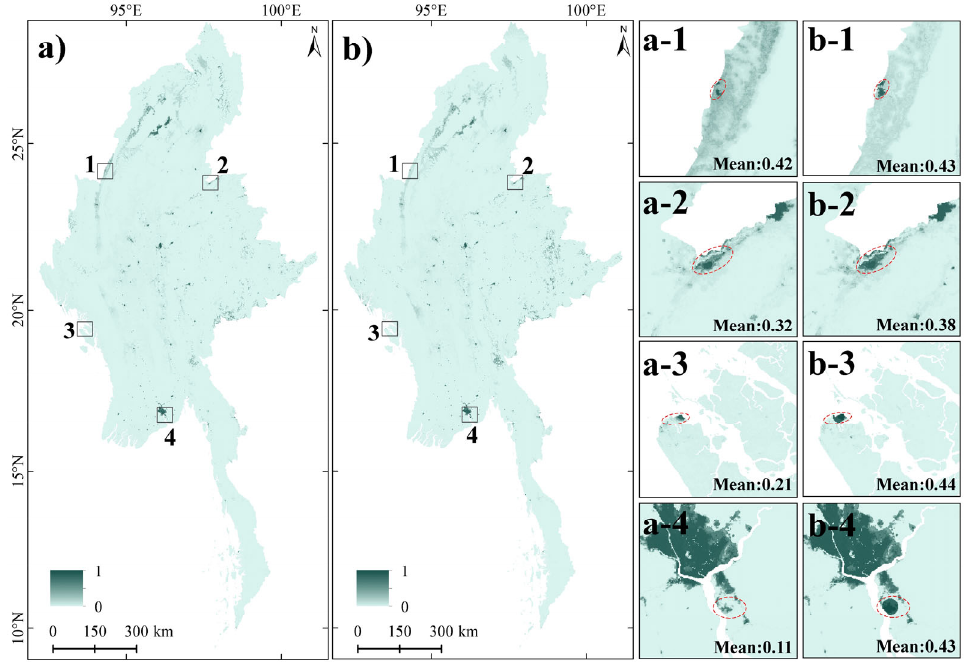
Figure 5. PoO surfaces of built ‐ up land ( a ) without and ( b ) with the impacts of planning policies for future simulation. Mean denotes the mean value of the PoO surface in the red frame.